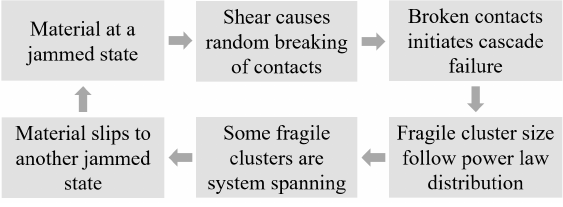
Figure 4. Mechanism of granular material moving from one jammed state to